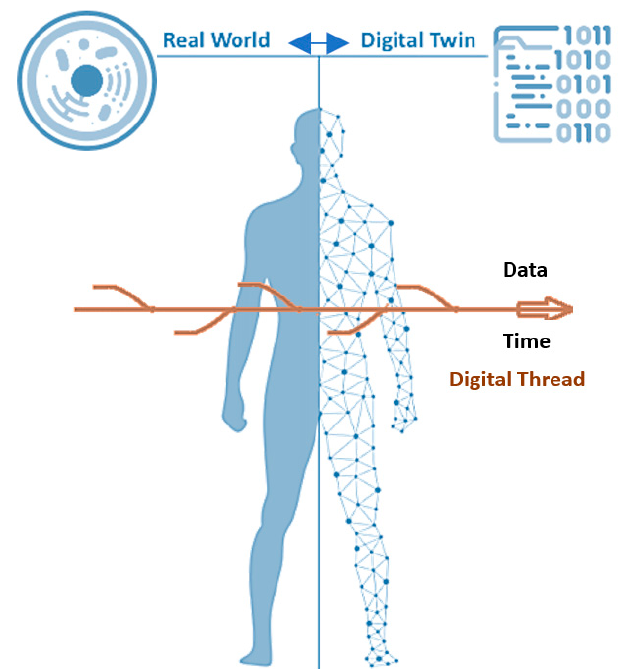
Figure 1. Composition of a digital twin. Note the bidirectional link between the real world (human body and its component parts) and the corresponding digital twin.